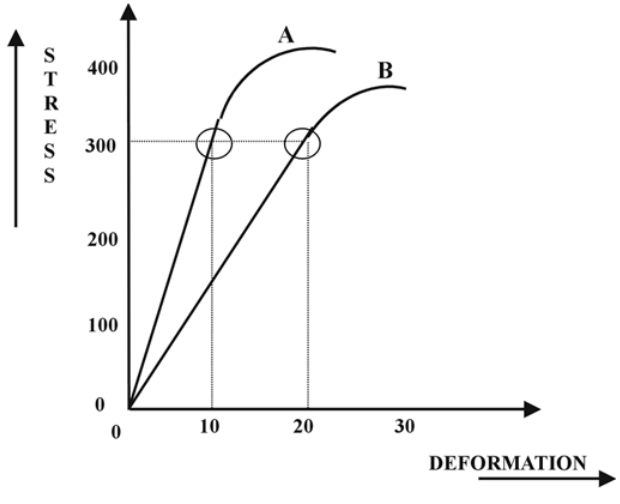
FIGURE 2- Stress-strain curve for hypothetical materials (A e B) showing that A (30GPa) presents higher elastic modulus than B (15 GPa)